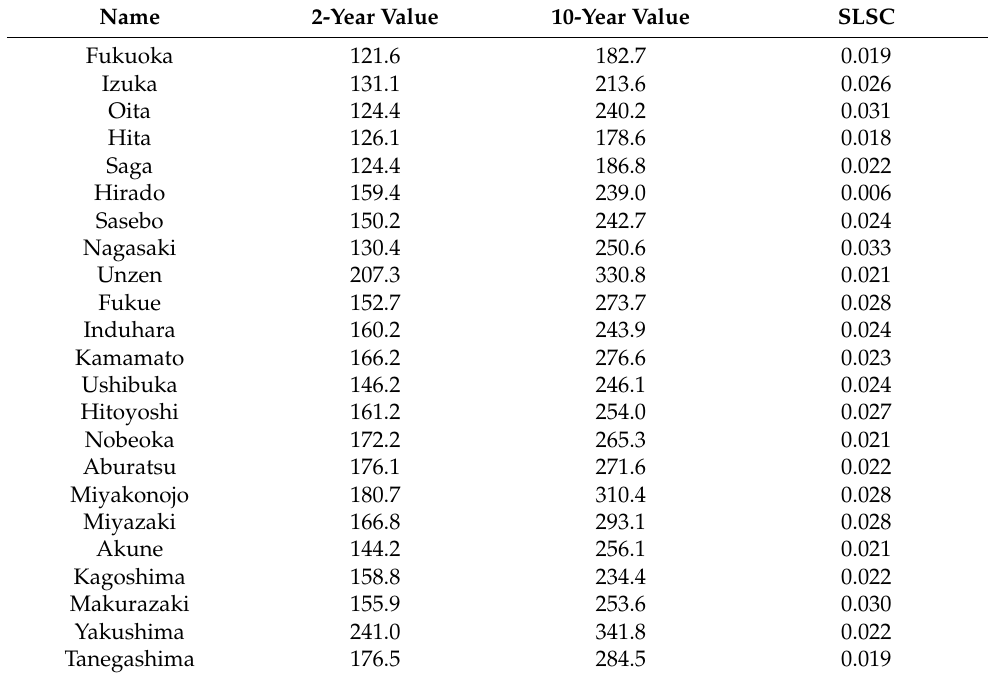
Table 3. The 2- and 10-year values at long-term record stations.